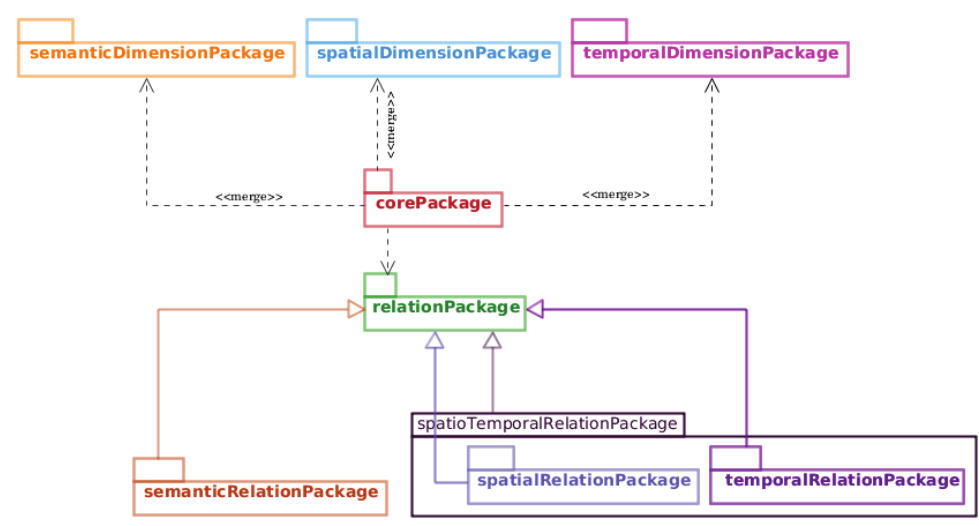
Figure 1: Spatiotemporal